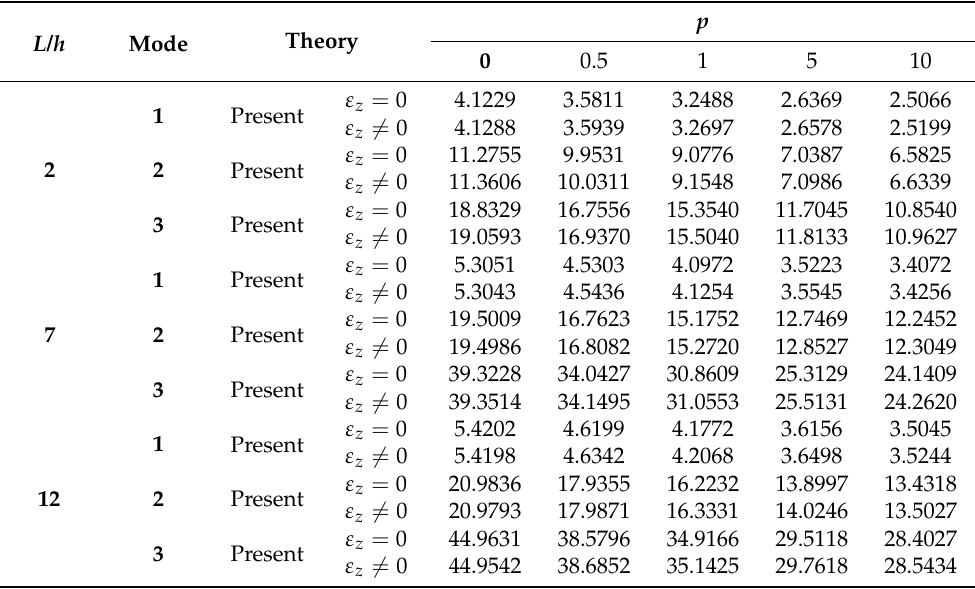
Table 5. Effect of slenderness ratio ( L / h ) on non-dimensional t fundamental frequency of the S-S FG beam for various material